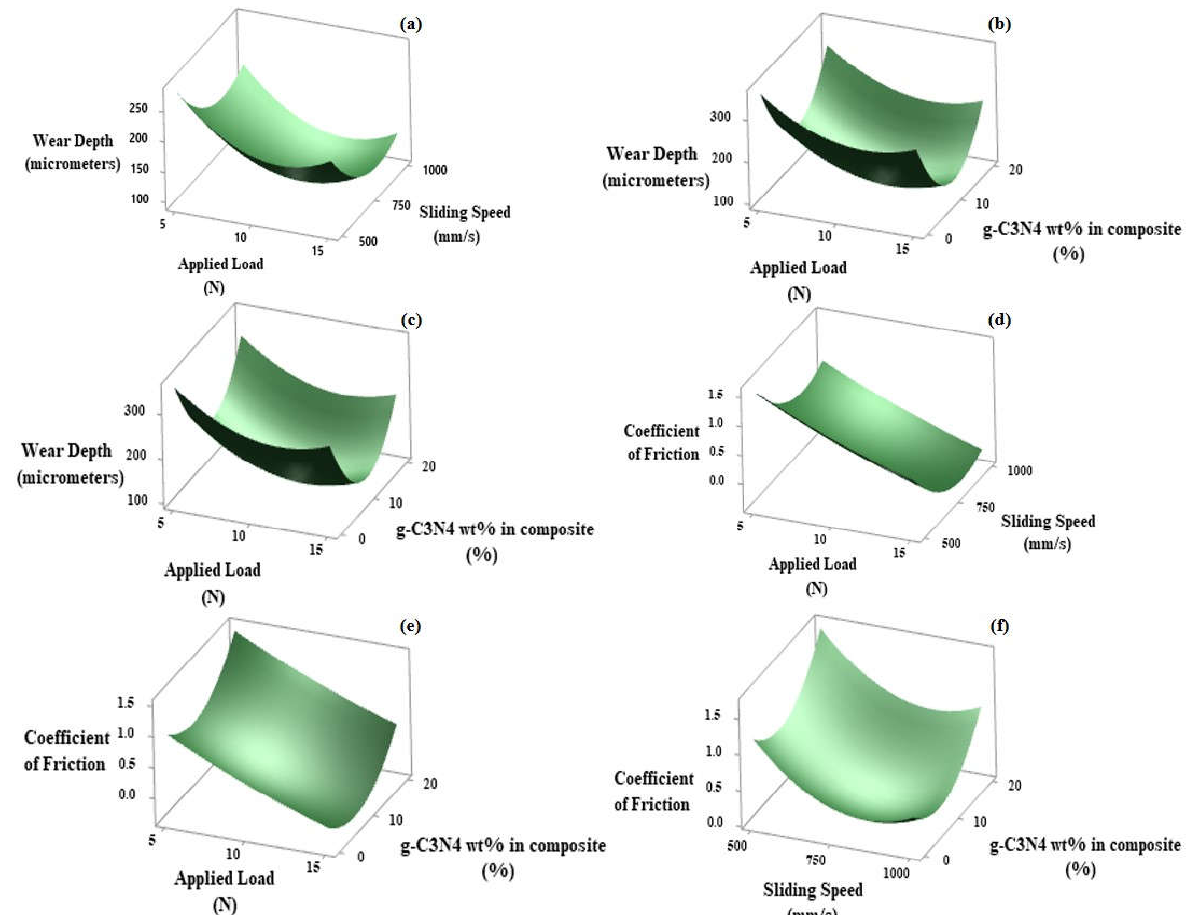
Figure 7. Response surface for wear depth and coefficient of friction for ( a,d ) applied load vs. sliding speed; ( b,e ) applied load vs. weight percent of g-C 3 N 4 in composite; ( c,f ) applied load vs. weight percent of g-C 3 N 4 in composite.